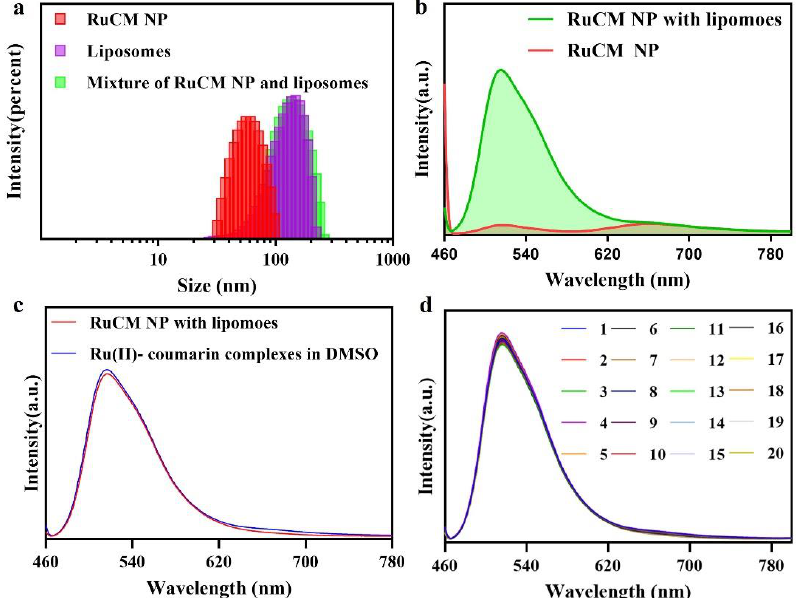
Figure 3. Liposomes selective labelling of RuCM NP. ( a ) DLS of the RuCM NP, liposomes and the mixture of liposomes and RuCM NP. ( b ) Fluorescence spectra of RuCM NP and the mixture of liposomes and RuCM NP. ( c ) Fluorescence spectra of RuCM NP and the mixture of liposomes and Ru(II)-coumarin complexes in DMSO; ( d ) photostability studies of Ru(II)-coumarin complexes after continuous 20 scans.